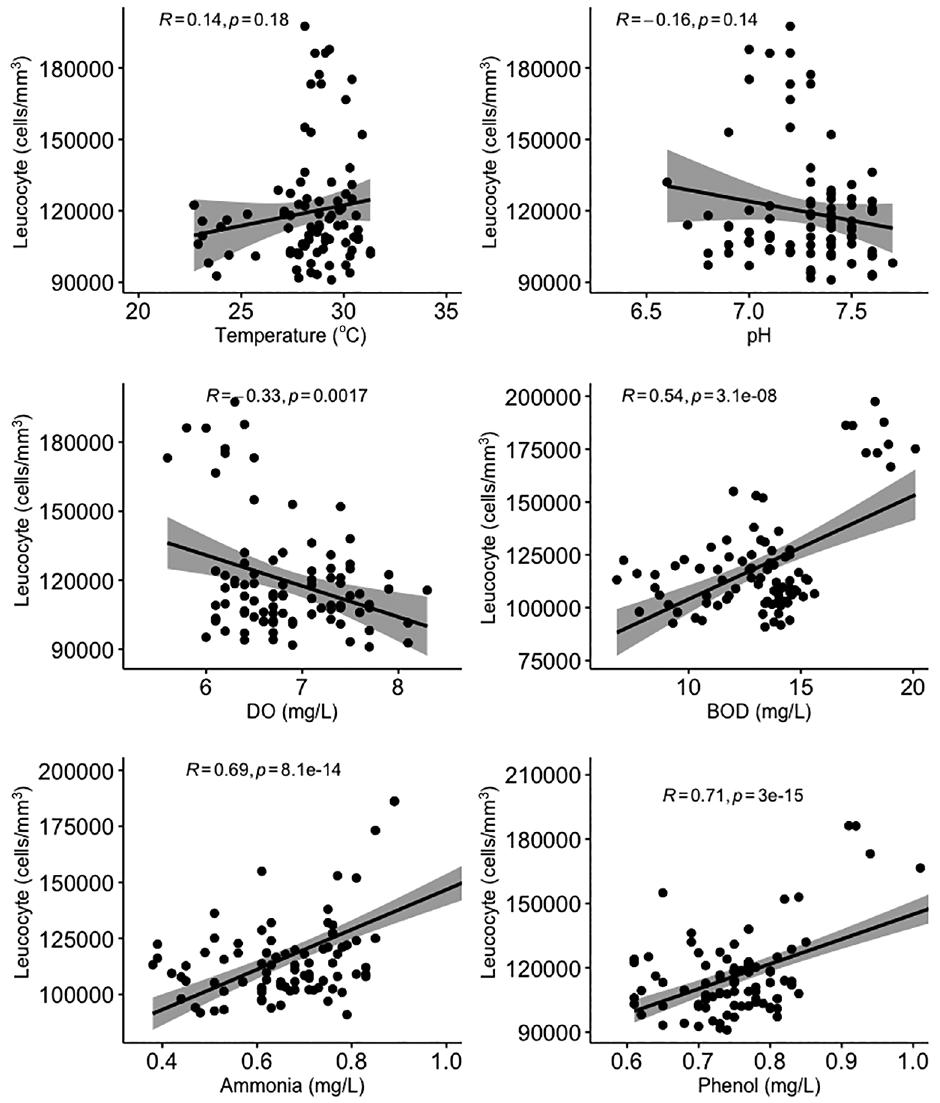
Figure 4. Scatter plot and Pearson correlation analysis between leucocyte and water quality parameters. DO = dissolved oxygen; BOD = biological oxygen